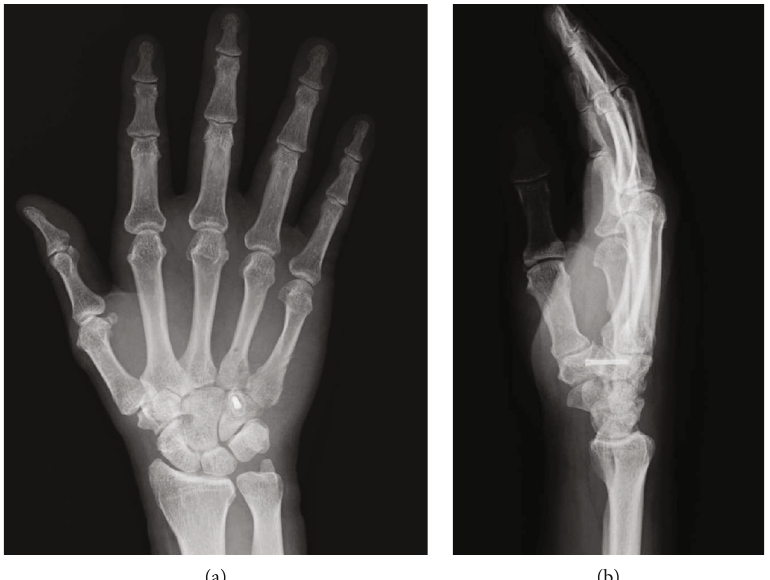
Figure 7: Radiographs after the removal of the K-wires showing the maintenance of the reduction of CMC joint. (a) Posteroanterior view. (b) Oblique semisupinated view.